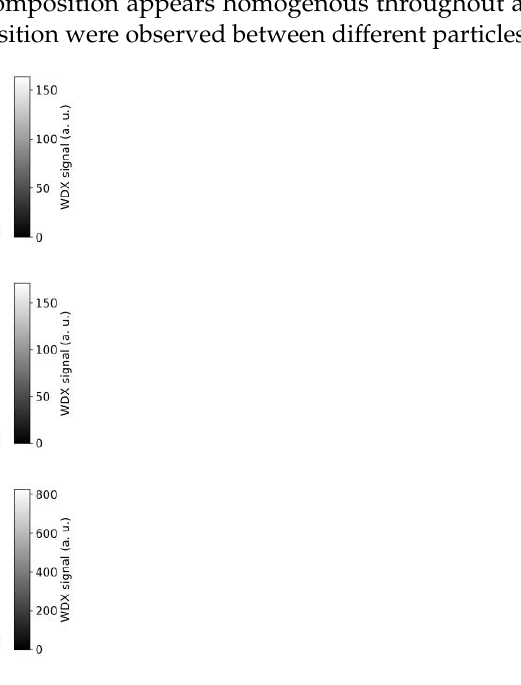
Figure 4. WDX signal of active materials from EMPA measurement for NMC 111 of Co, Ni and Mn.